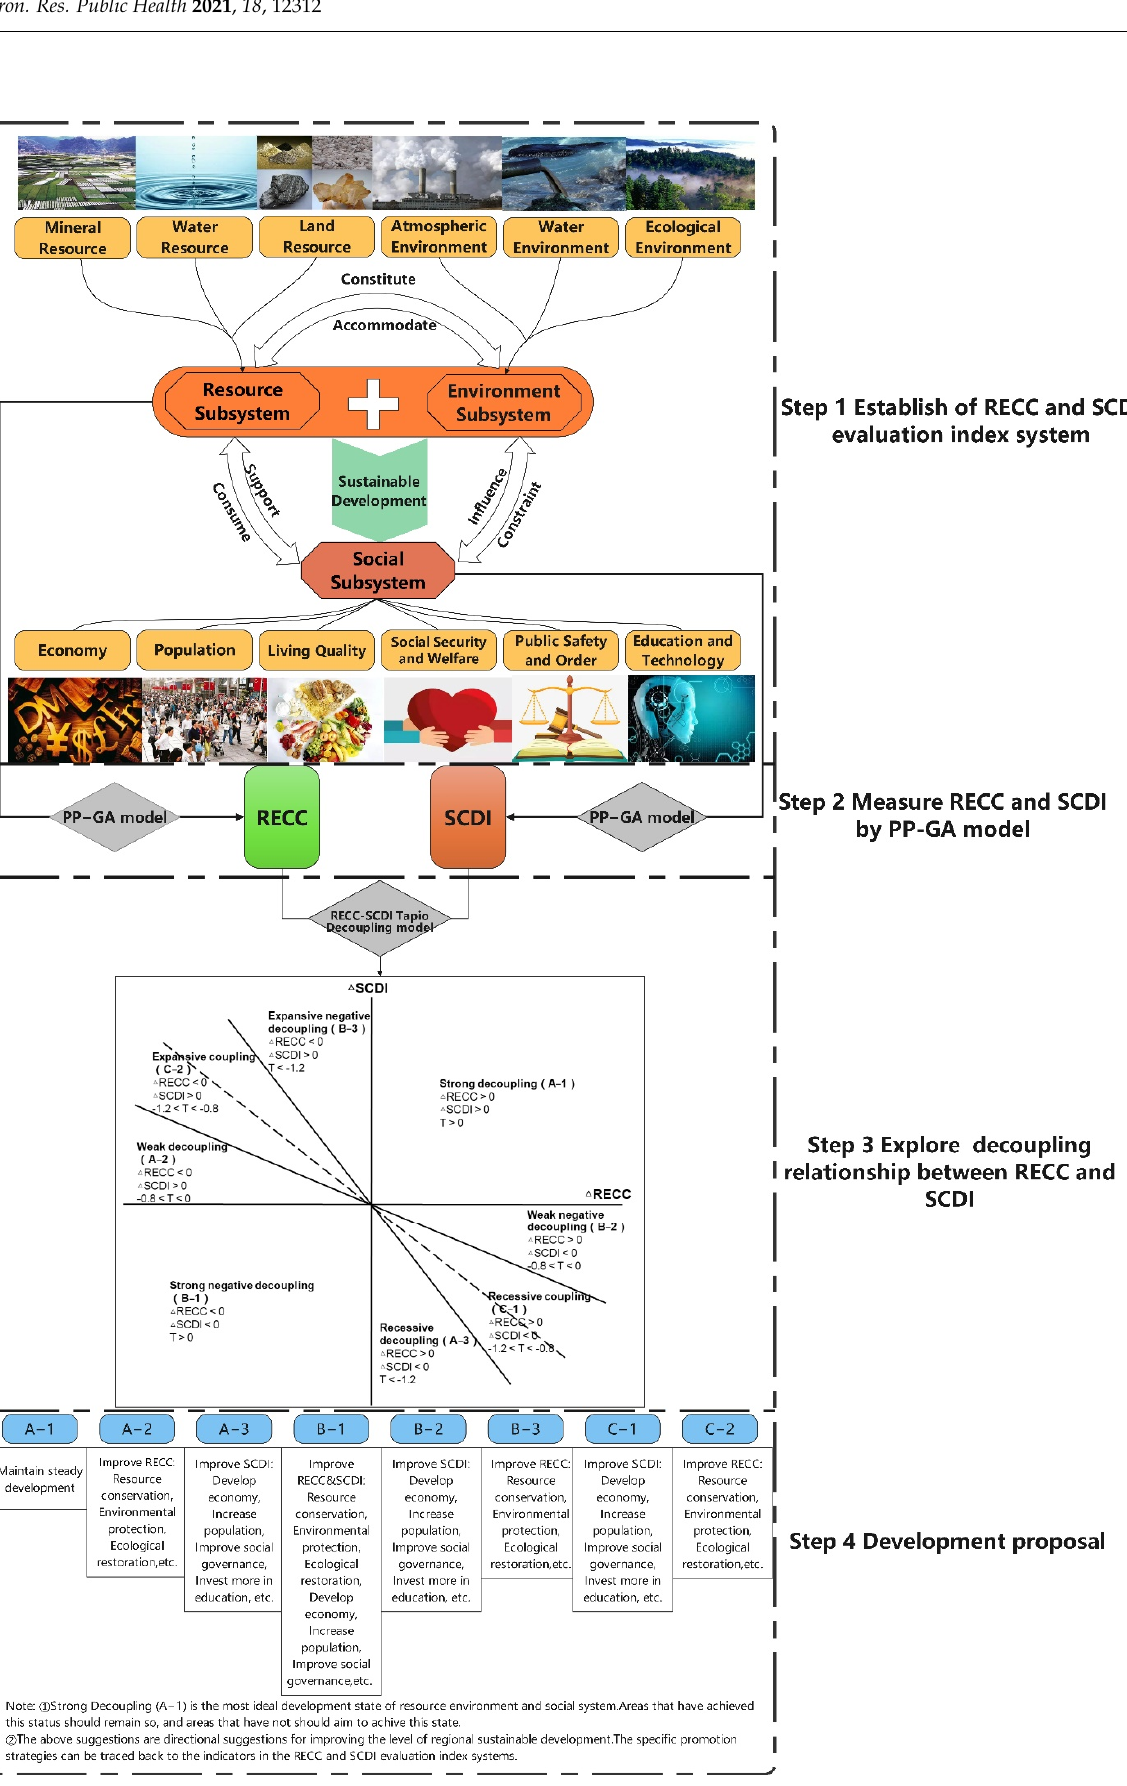
Figure 1. Research framework.